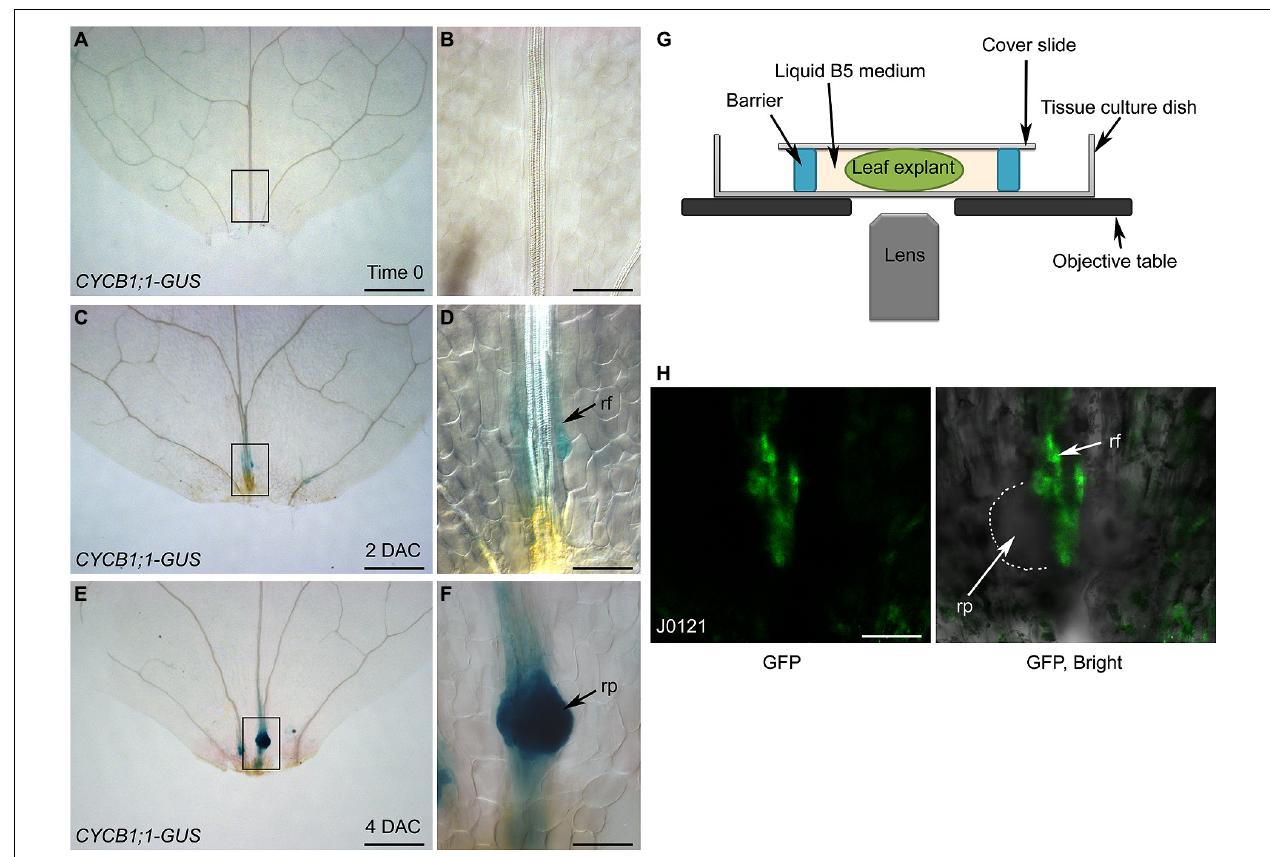
FIGURE 4 |Analysis of cell lineage by DIC and confocal microscopies. (A–F) GUS staining of time-0 (A,B) , 2-DAC (C,D) , and 4-DAC (E,F) leaf explants from CYCB1;1-GUS plants, cultured on B5 medium. (B,D,F) show magnifications of boxed regions in (A,C,E) , respectively. Leaf explants were